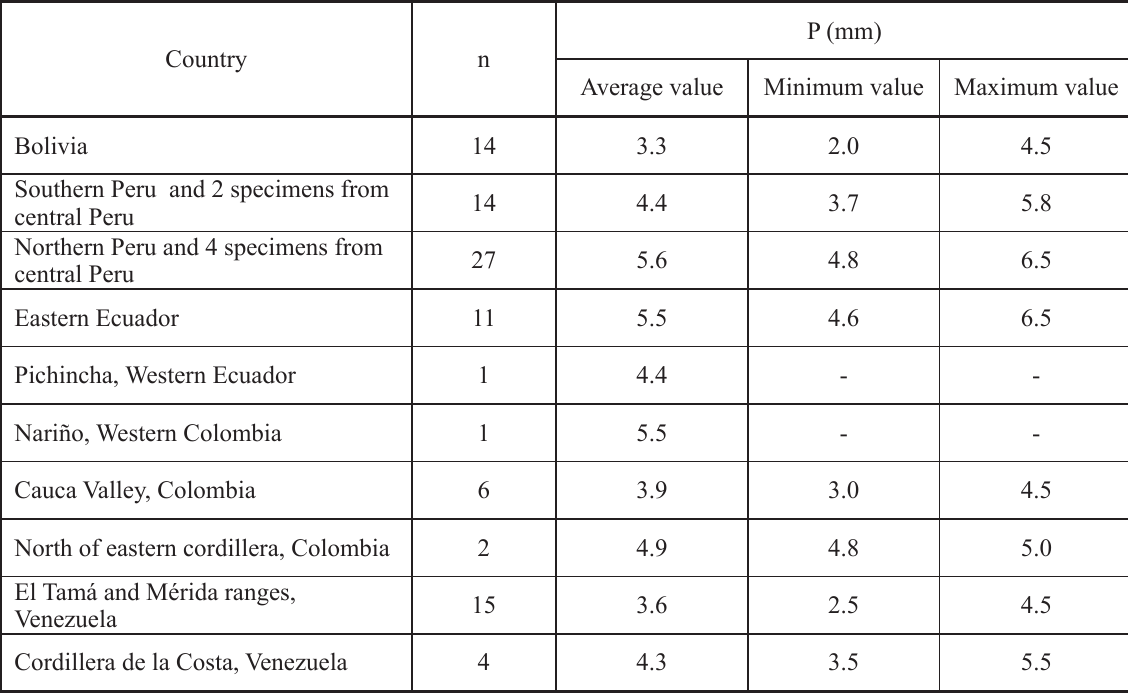
Table 3. Variation of the hindwing projection index P in males (n = number of individuals on which measurements have been made, directly or on scaled